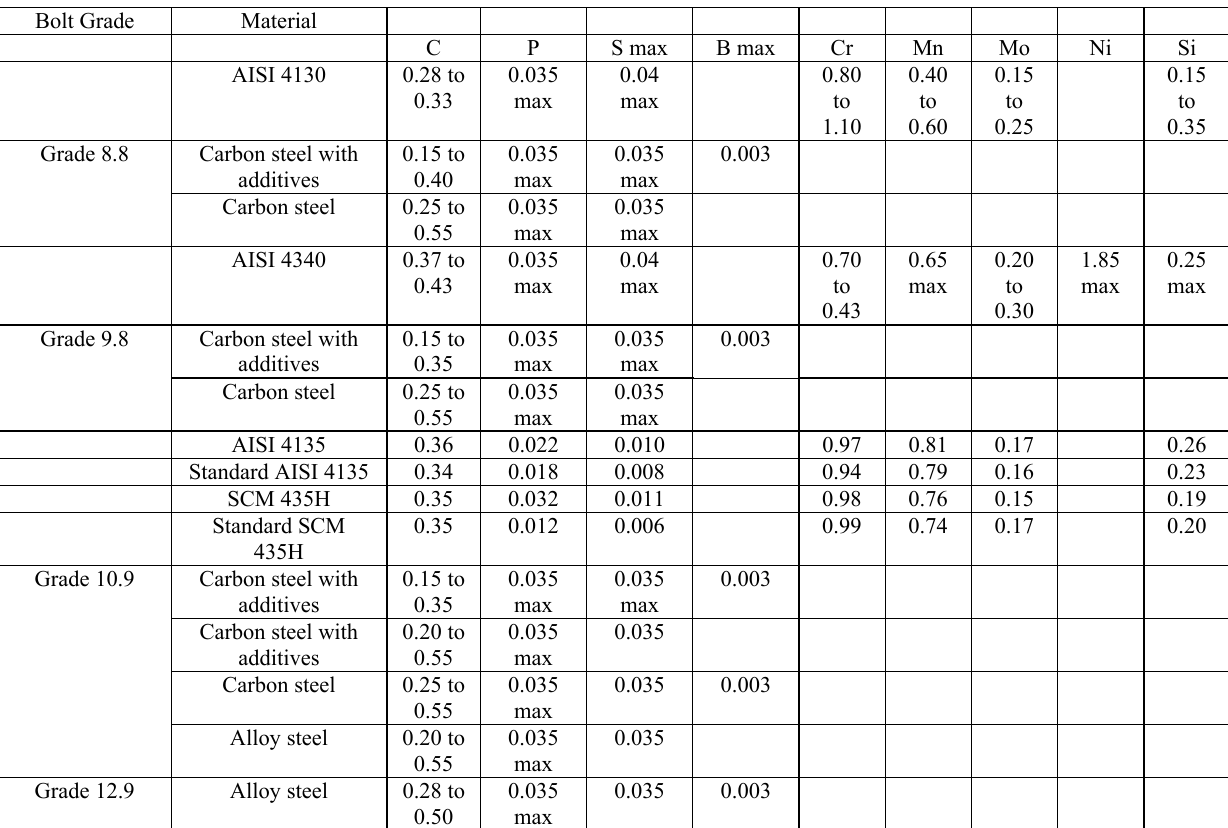
Table 3. Chemical composition of materials. Bolt